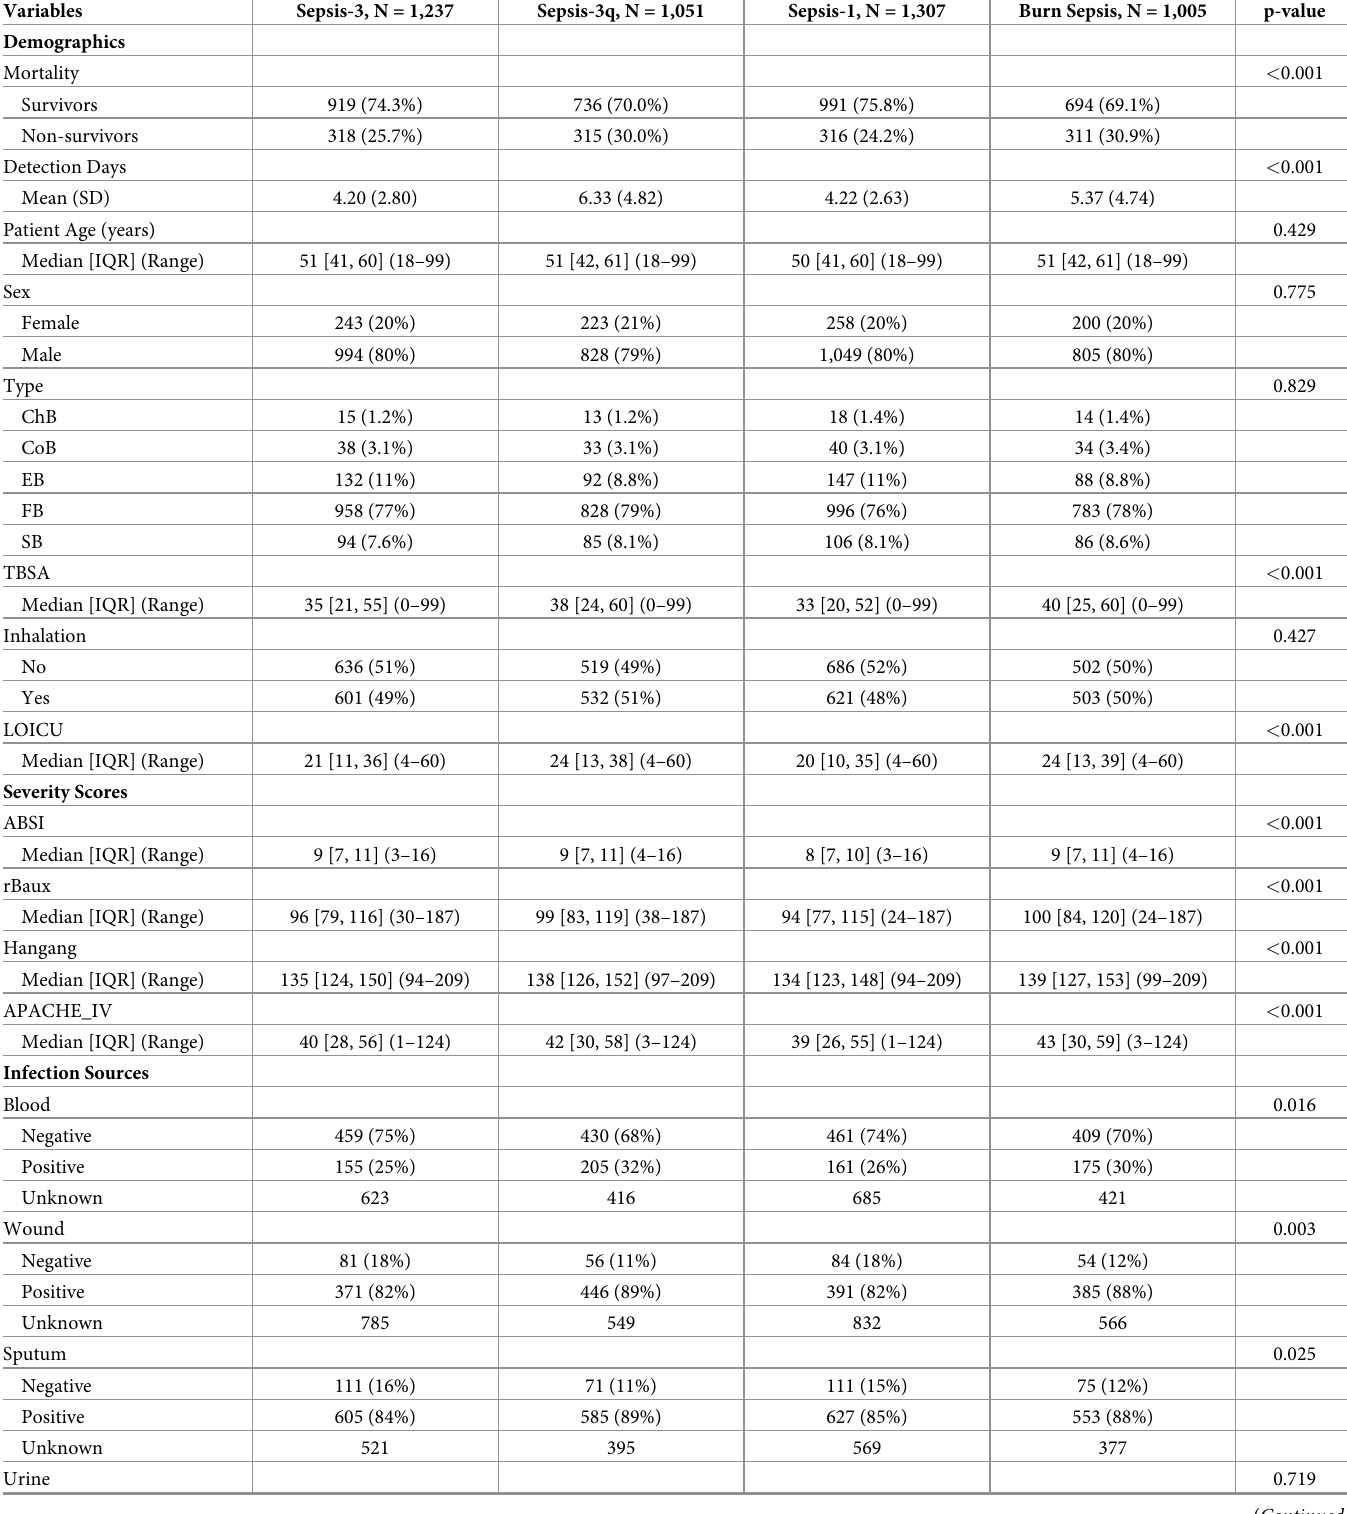
Table 1. Demographics and infection sources according to sepsis